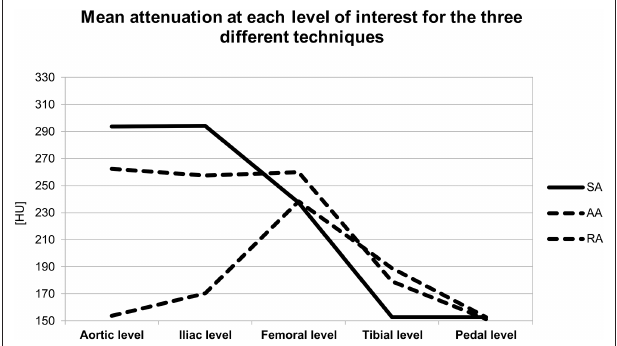
FIGURE 2 | Graph represents the mean attenuation in HU at each level of interest for the three different acquisition techniques. HU, Hounsfield units; SA, standard acquisition technique; AA, adaptive acquisition technique; RA, retrograde acquisition technique.